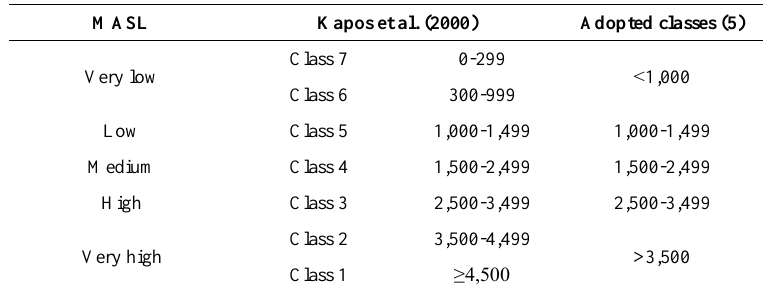
Table 3. Adopted MASL classes for health tourism